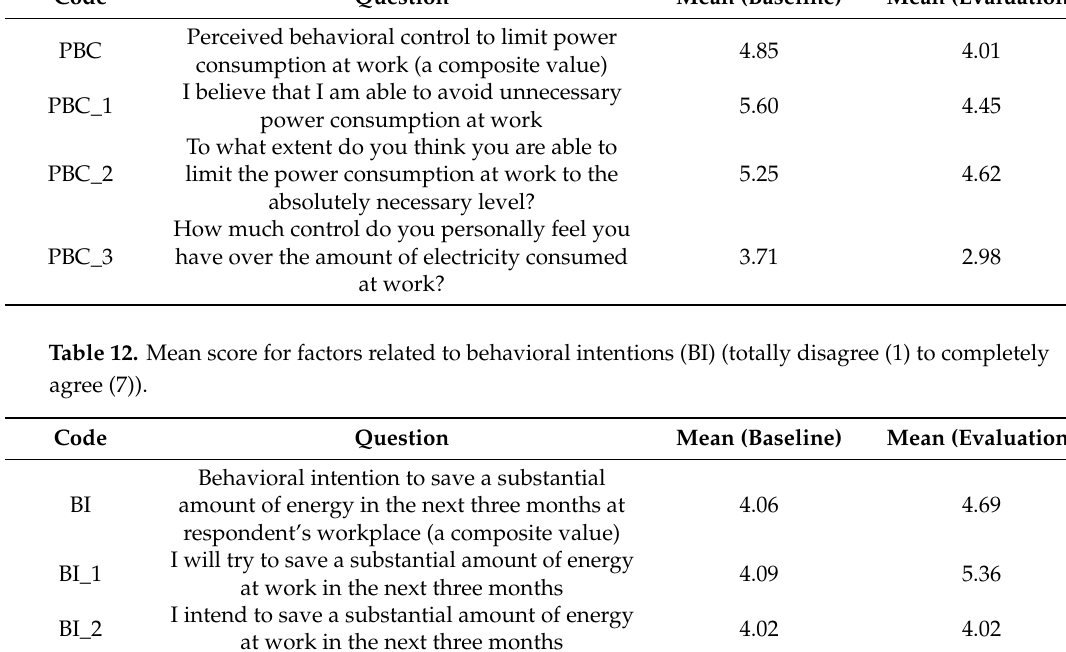
Figure 5. A comparison of perceived subjective norms in Greek public buildings (before and after the trial). The answers to the baseline survey questions demonstrated that neither the superiors (4.50) nor the co-workers (4.56) or people who were important to the respondents’ private lives (3.71) believed that the respondents should save energy at work. In contrast, after one year of intervention had passed, the subjective norm scores changed from negative/neutral to positive (5.79, 5.62, and 4.55, respectively; see Table 9). Both the baseline and evaluation surveys contained a question regarding the energy-saving– comfort trade-off. The respondents had to indicate what is more important for them—feeling comfortable (1) or saving energy (7). It is worth noting that, even before the enCOMPASS trial started, the employees in the pilot study felt that saving energy was more important than feeling comfortable (4,48). Therefore, it is not surprising that their opinions did not change a lot over the duration of the project (see Figure 6). Figure 6. A comparison of energy-saving–comfort trade-off scores in Greek public buildings (before and after the trial).